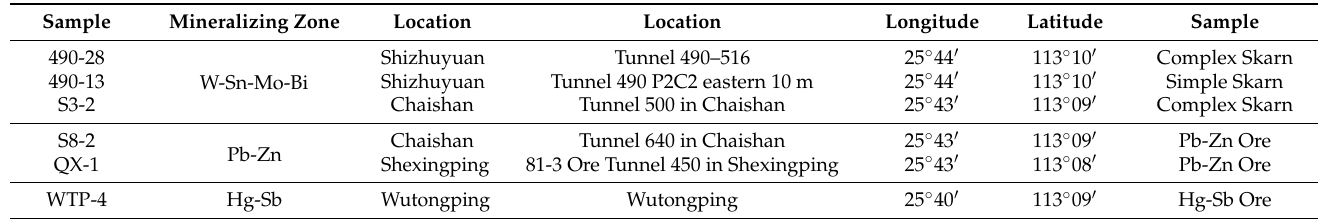
Table 1. Samples collected from three mineralizing zones in the Shizhuyuan